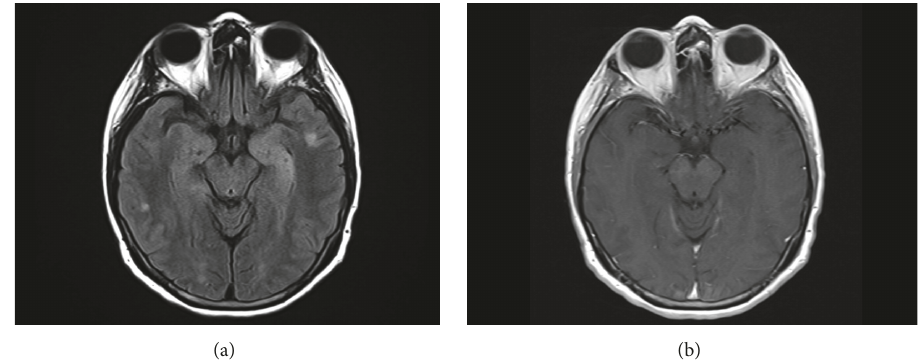
Figure 2: MRI brain imaging for Case 2. (a) MRI brain FLAIR imaging. This image demonstrates mildly expansile T2 signal hyperintensity of the left greater than right mesial temporal lobes. Additional small regions of cortical and subcortical T2 signal hyperintensity are noted in the temporal lobes of both hemispheres. (b) MRI brain, T1 sequence with contrast. There is no enhancement noted in the affected areas after administration of gadolinium